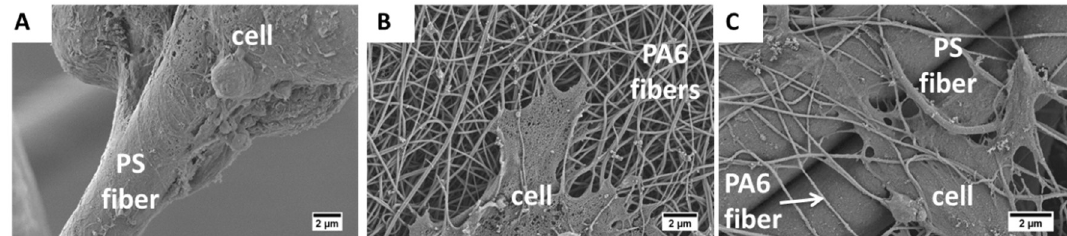
Figure 5. SEM micrographs focused on cell–fiber attachment after the 3rd day of cell culture on ( A ) PS microfibers; ( B ) PA6 nanofibers and ( C ) hierarchical PS-PA6 composite meshes.